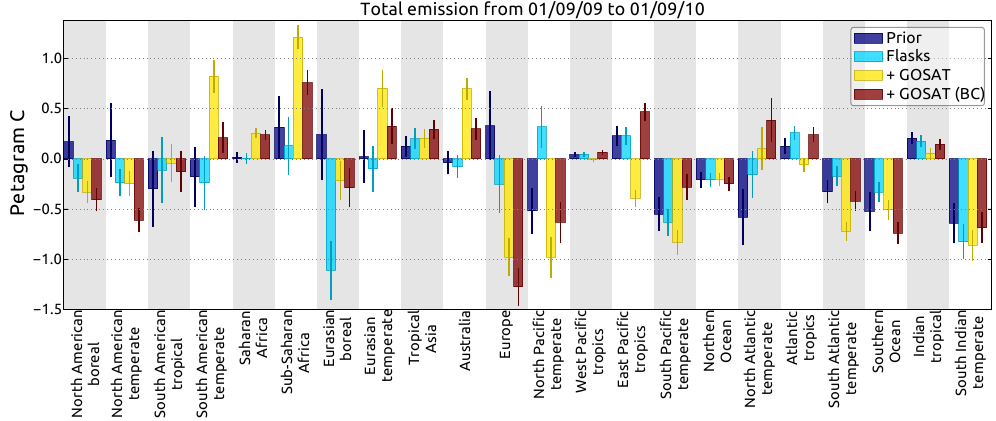
Fig. 12. The optimized flux over the 22 TRANSCOM regions from a joint inversion optimizing bias parameters defined in Eq. 12 (denoted “+ GOSAT (BC)”), compared to the joint inversion shown in Fig. 7 (denoted “+ GOSAT”).